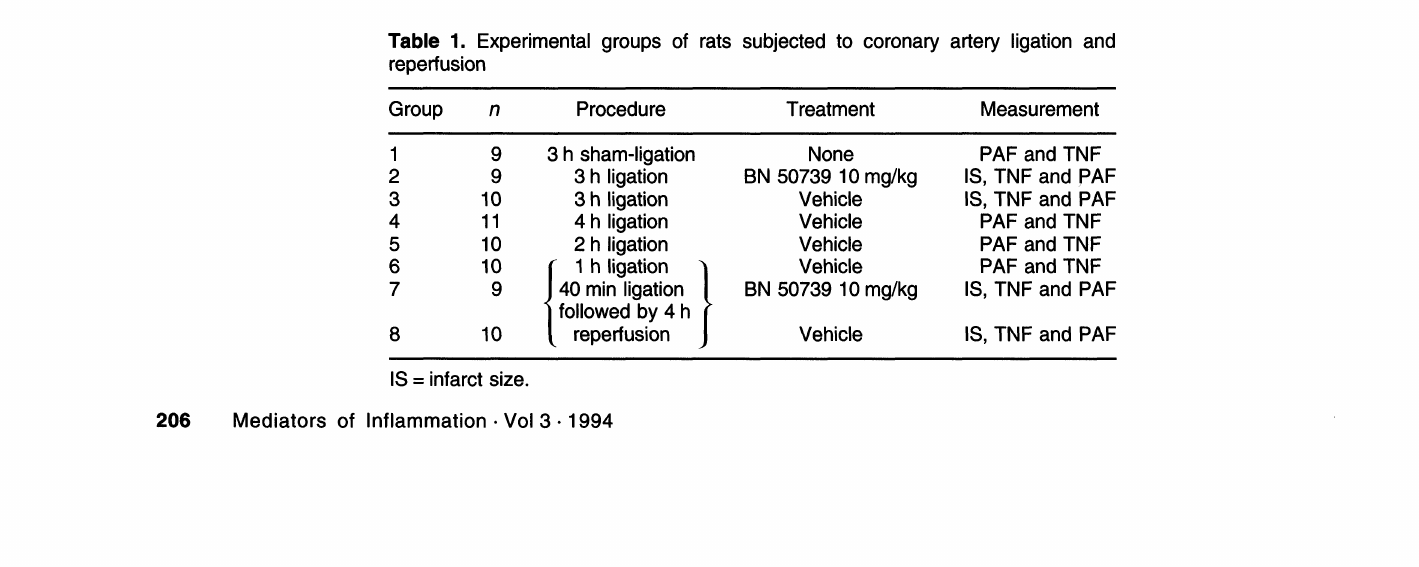
Table 1. Experimental groups of rats subjected to coronary artery ligation and repeffusion